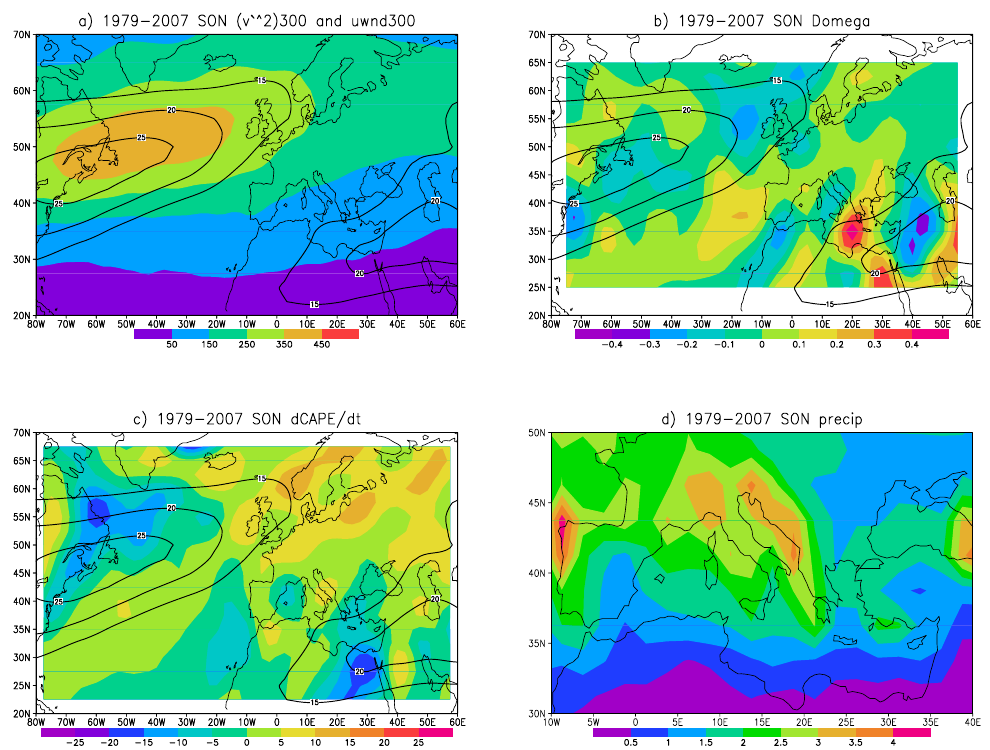
Fig. 5. Fall climatology: (a) stormtrack (m 2 s − 2 ); (b) vertical velocity increment in the upper troposphere (hPas − 1 ); (c) CAPE tendency in the lower troposphere (100JKg − 1 s − 1 ); the zonal wind at 300hPa is superimposed in black contours (5ms − 1 interval beginning at 15ms − 1 ) ; (d) rainfall (mmday − 1 ).